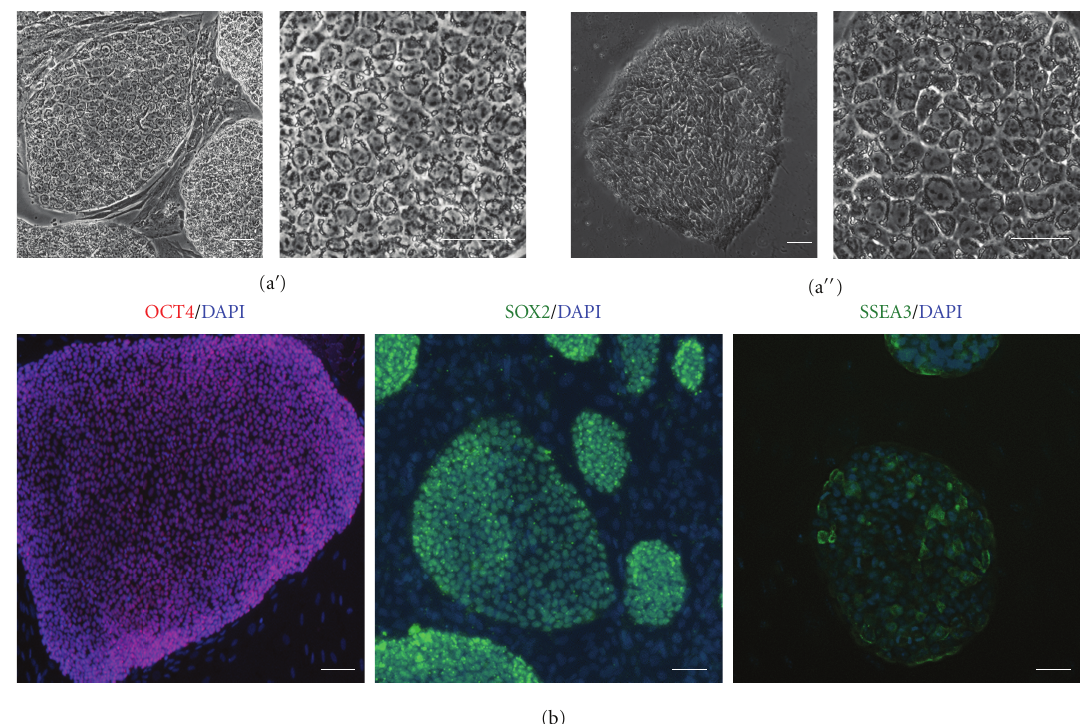
Figure 1: Cjes001 common marmoset embryonic stem cells (CESCs) closely resemble the morphology of human pluripotent stem cells. (a (cid:3) ) Colonies of CESCs grown on irradiated feeder cells (4x magnification, left) and morphology of individual CESCs at 20x magnification (right). (a (cid:3)(cid:3) ) Morphology of Riv9 HIPSC colony (4x mag, left) and individual cells within the colony (20x, right). (b) Immunocytochemical analysis of CESCs showing nuclear localization of OCT4 (red), SOX2 (green), and stage-specific embryonic antigen-3 (SSEA3, green). Cell nuclei were counterstained with DAPI. Scale bars, 50 μ